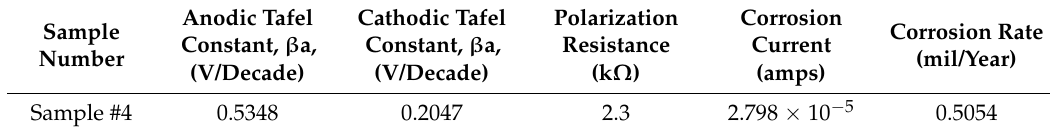
Table 1. Tafel plot measurement details of Sample